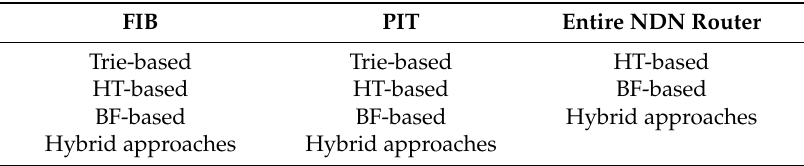
Table 1. Classification of NDN name lookup approaches.